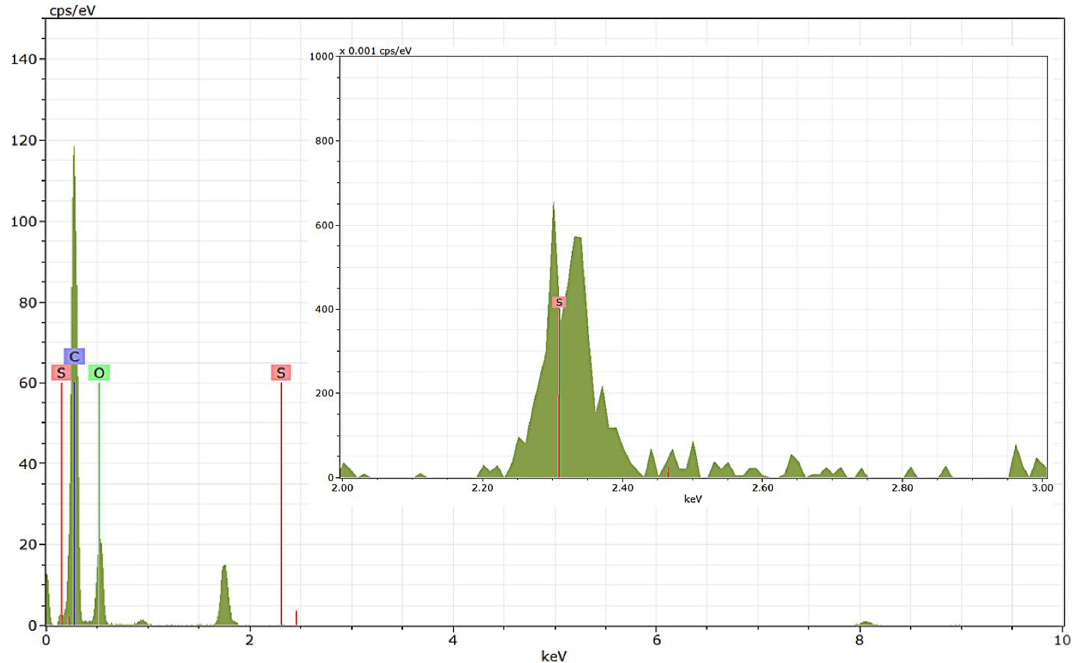
Figure C8. EDX spectra for AOI of thickly coated mCASTblack soot (H 2 SO 4 coating wt = 30.2%) presented in Fig. 10. The x axis stands for the electron energy (keV) and the y axis represents counts per second per eV (cpseV − 1 ). The position of carbon (C), oxygen (O) and sulfur (S) is indicated in the figure. The zoom-in patch shows the sulfur region of the spectra, which is not legible in the main spectrum.